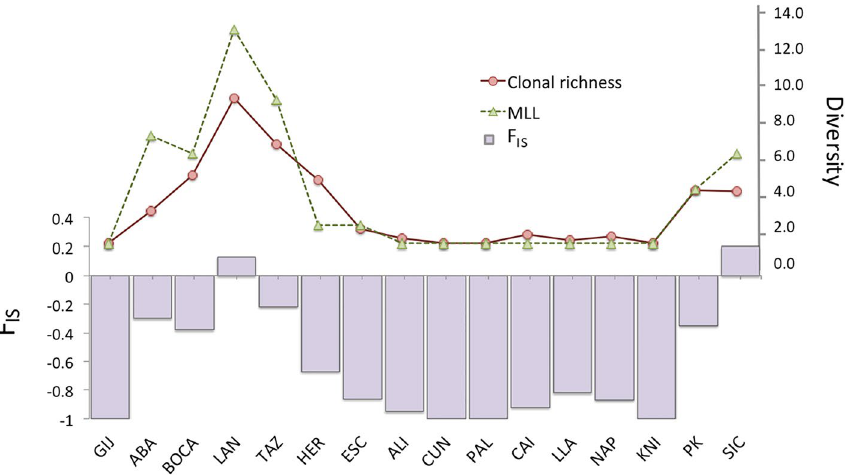
Figure 2. F IS versus genetic diversity in Coscinasterias tenuispina, including all individuals. Graph representing the F IS value per locality (left y -axis) versus clonal richness and number of MLLs per locality (solid red line and dotted green line, respectively) (right y